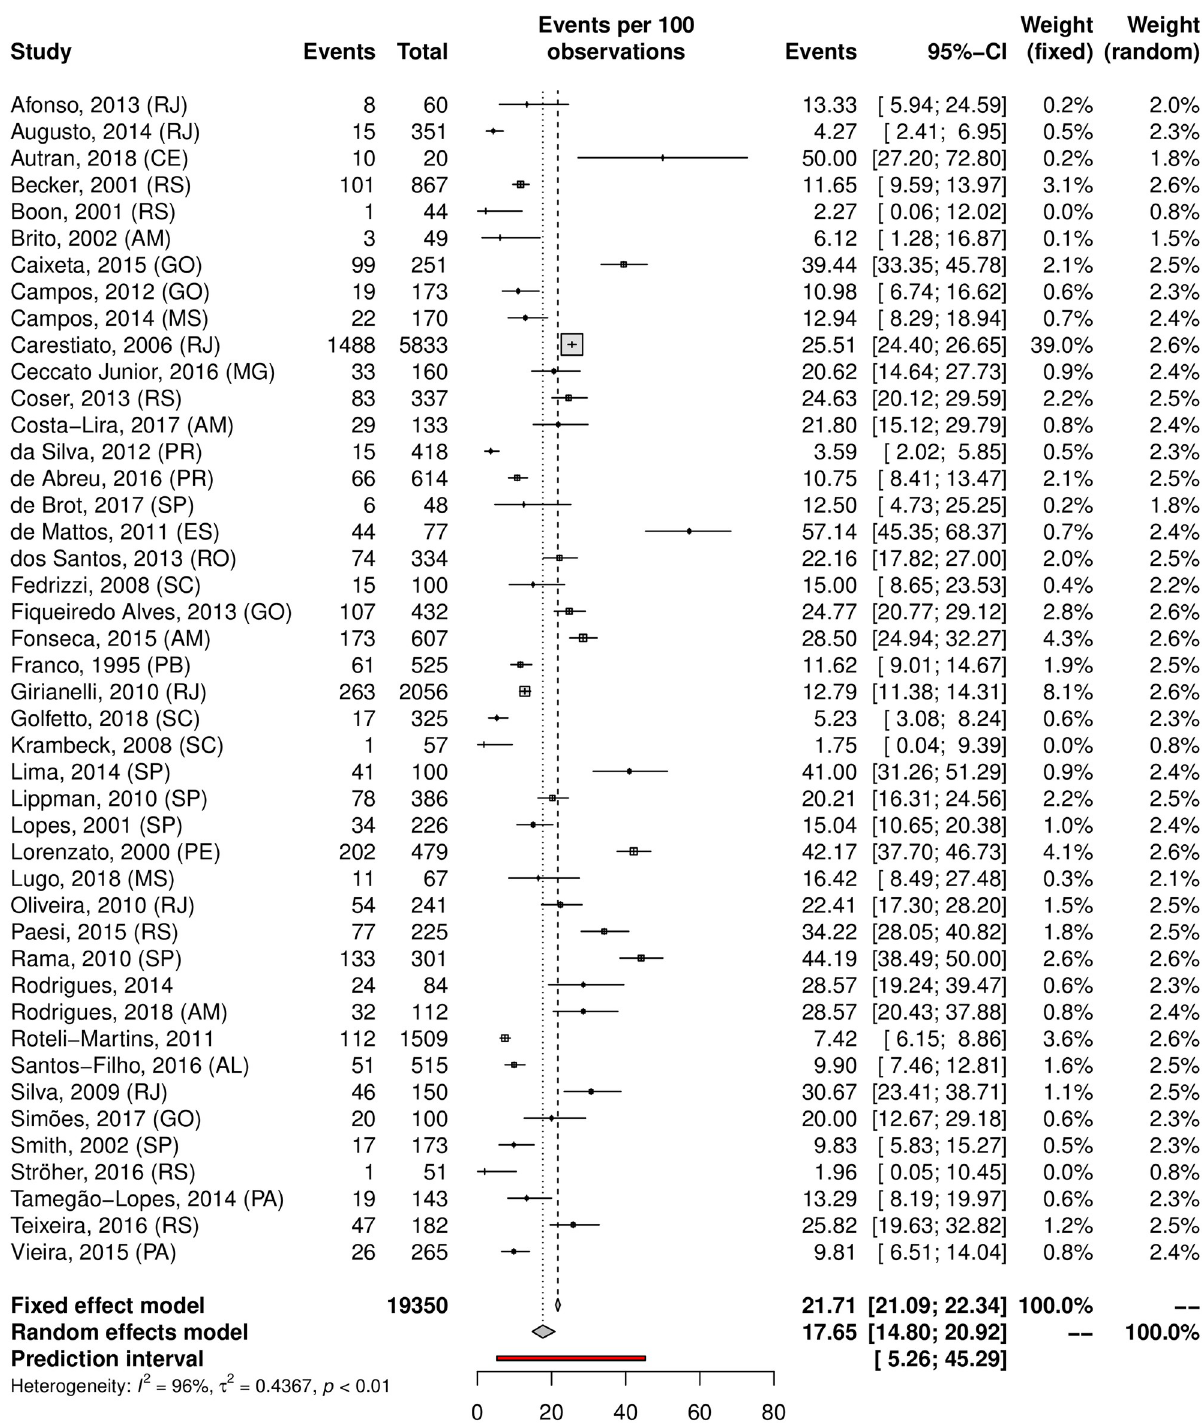
Fig 2. Overall prevalence of cervical infection by high-risk HPV genotypes. Forest plot of a metanalysis of studies reporting prevalence of infection of the cervix by HR-HPV genotypes in Brazil.